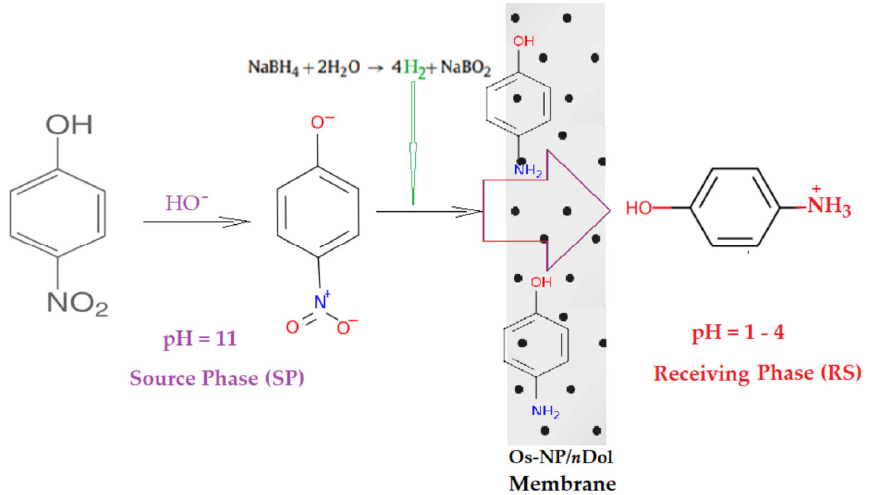
Figure 13. Schematic presentation of the reduction process of p –nitrophenol ( p NP) and transport